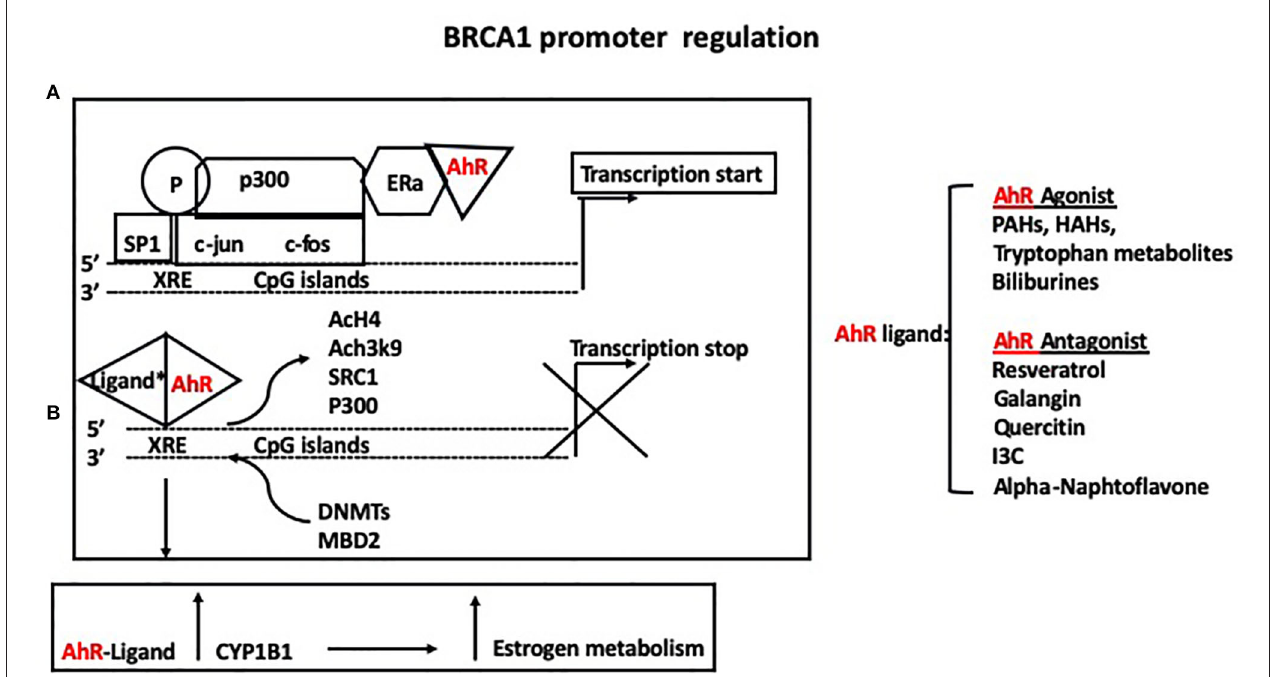
FIGURE 2 | (A) The aromatic hydrocarbon receptor (AhR) binds directly to the BRCA1 promoter and activates its expression in the presence of estrogen. (B) However, in the presence of either agonists or antagonists, the bound AhR is recruited to xenobiotic responsive elements (XRE = 5 ′ -GCGTG-3 ′ ) harbored in the BRCA1 promoter and inhibits its estrogen-mediated transactivation, by blocking the recruitment of ER, p300, SRC1, and histone modifications (i.e., AcH4, AcH3K9) that enhance transcription while promoting the association of factors (DNMTs, and methyl binding domain proteins such as MBD2) and histone modifications (H3K9me3, H3K27me3) that repress transcription. Binding of the xenobiotic TCDD activates AhR-mediated activity of P450 enzymes, including CYP1B1, which mediates estrogen